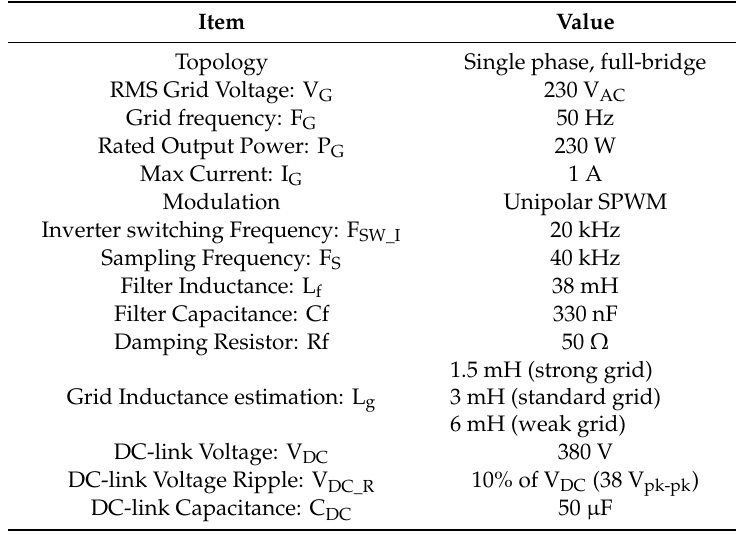
Table 1. Values of the Voltage Source Inverter (VSI)